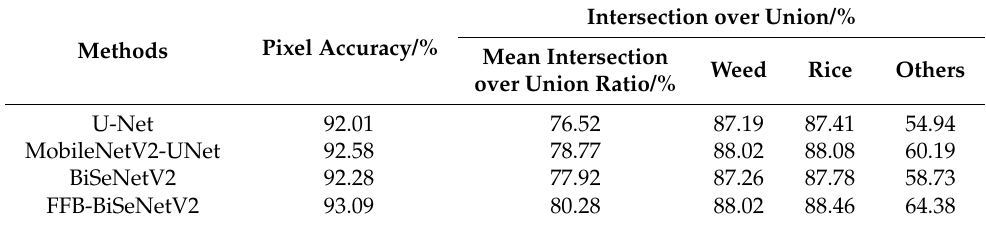
Table 1. Comparison of segmentation precision of different models.